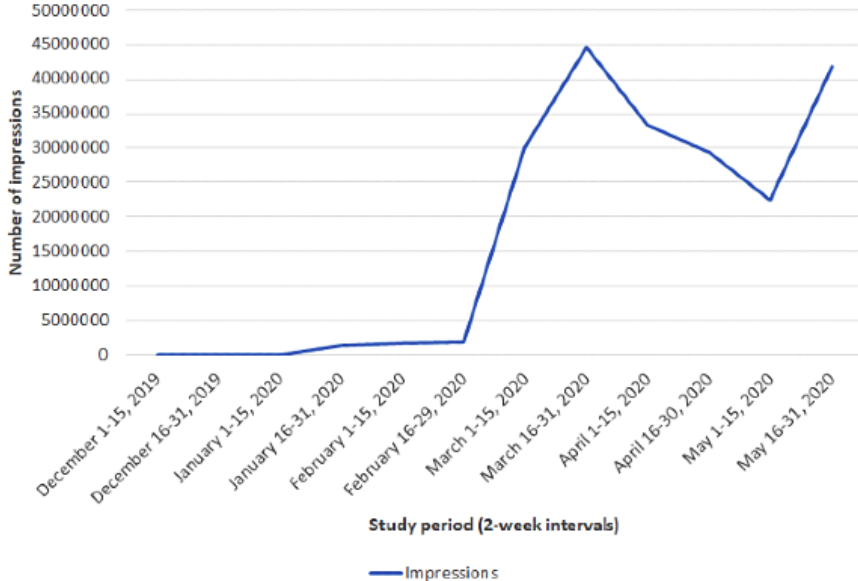
Figure 3. Trend of COVID-19 Twitter impressions. Number of impressions generated from Twitter from December 1, 2019, through May 31, 2020, captured at half-month intervals by using the Twitter analytics platform Symplur